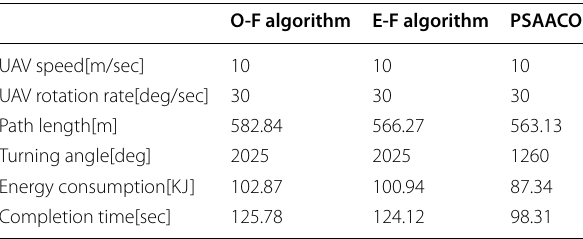
Table 15 Experiments on area 4 for performance comparison between PSAACO and algorithm in